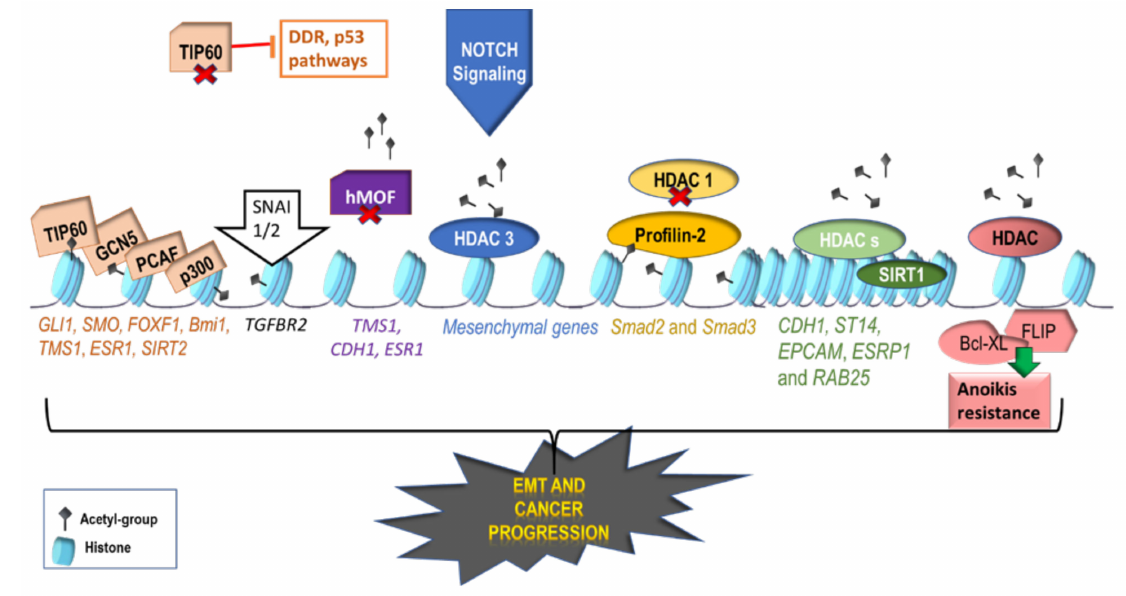
Figure 2. Histone acetylation regulates genes involved in cancer progression. Histone acetylation is an activating histone modification that favors gene transcription. H3K4Ac marks are present on the promoters of several genes, GLI1 , SMO , FOXF1 , Bmi1 , and SIRT2 , which are upregulated in cancer, favoring tumor progression. Upon SNAI1/2 activation, increased H3K9 acetylation has been observed on the promoter of TGFBR2 , causing its upregulation. Critical acetyltransferases TIP60, GCN5, PCAF, and p300 catalyze histone acetylation of metastasis-promoting genes. hMOF, a H4K16 histone acetyltransferase normally maintains the expression of EMT-related tumor suppressor genes, such as TMS1, CDH1 , and ESR1 , but is often downregulated in cancer. TIP60 is also commonly downregulated in various tumors, where it prevents the activity of anti-tumor DDR and p53 pathways, indicating how reduction in histone acetylation promotes cancer progression. HDAC3 can also be detected on the promoters of activated mesenchymal genes, even though most HDACs are associated with gene repression. Upon Notch signaling activation, H3K4Ac is removed by HDAC3, allowing for Notch-mediated expression of EMT-related genes. Profilin-2 interacts with HDAC1 and inhibits its binding to the promoters of Smad2 and Smad3 , causing Smad protein activation and subsequently enhancing TGF- β -induced EMT and angiogenesis. HDACs also catalyze H3K4/56 deacetylation at the CDH1 promoter, thus repressing E-cadherin. Similarly, HDAC1 and 2 are recruited by ZEB1 to CDH1 promoter, inducing its repression. In the same context, ZEB1 recruits SIRT1, a nicotinamide adenine dinucleotide (NAD)-dependent deacetylase, associated with a global H3K27 deacetylation and reduced H3K9Ac and H3K27Ac levels on the promoters of CDH1 and other epithelial genes, such as EPCAM , ST14, ESRP1 , and RAB25 , promoting EMT and metastasis. Finally, overexpression of FLIP leads to the upregulation of the anti-apoptotic Bcl-XL, inhibiting the anoikis apoptotic pathway. HDAC inhibition prevents this outcome by reducing FLIP levels and inducing apoptosis of cancer cells, suggesting that HDACs participate in anoikis resistance of cancer cells through yet unknown